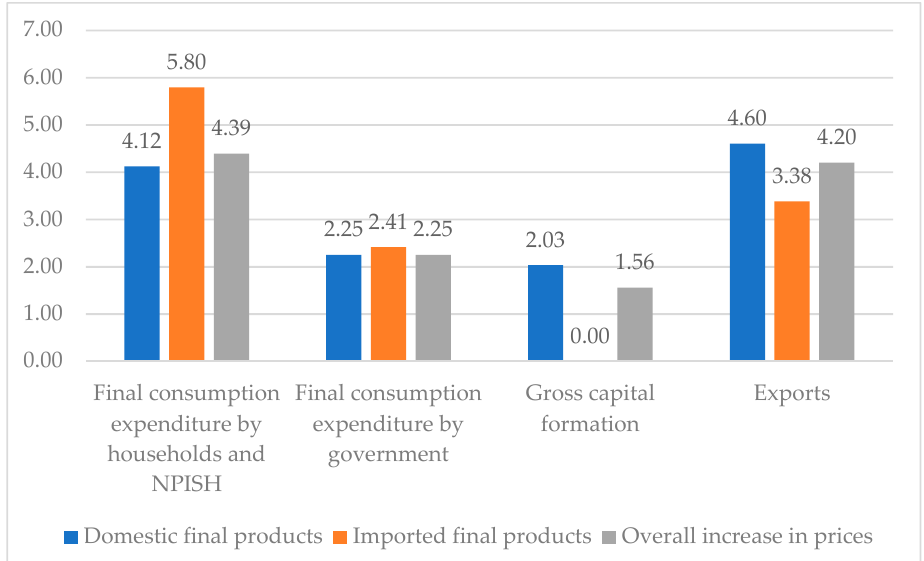
Figure 3. The highest price increase due to a 63% increase in energy prices, in %. Source: author. Different categories of final demand have a different share of energy expenditure,